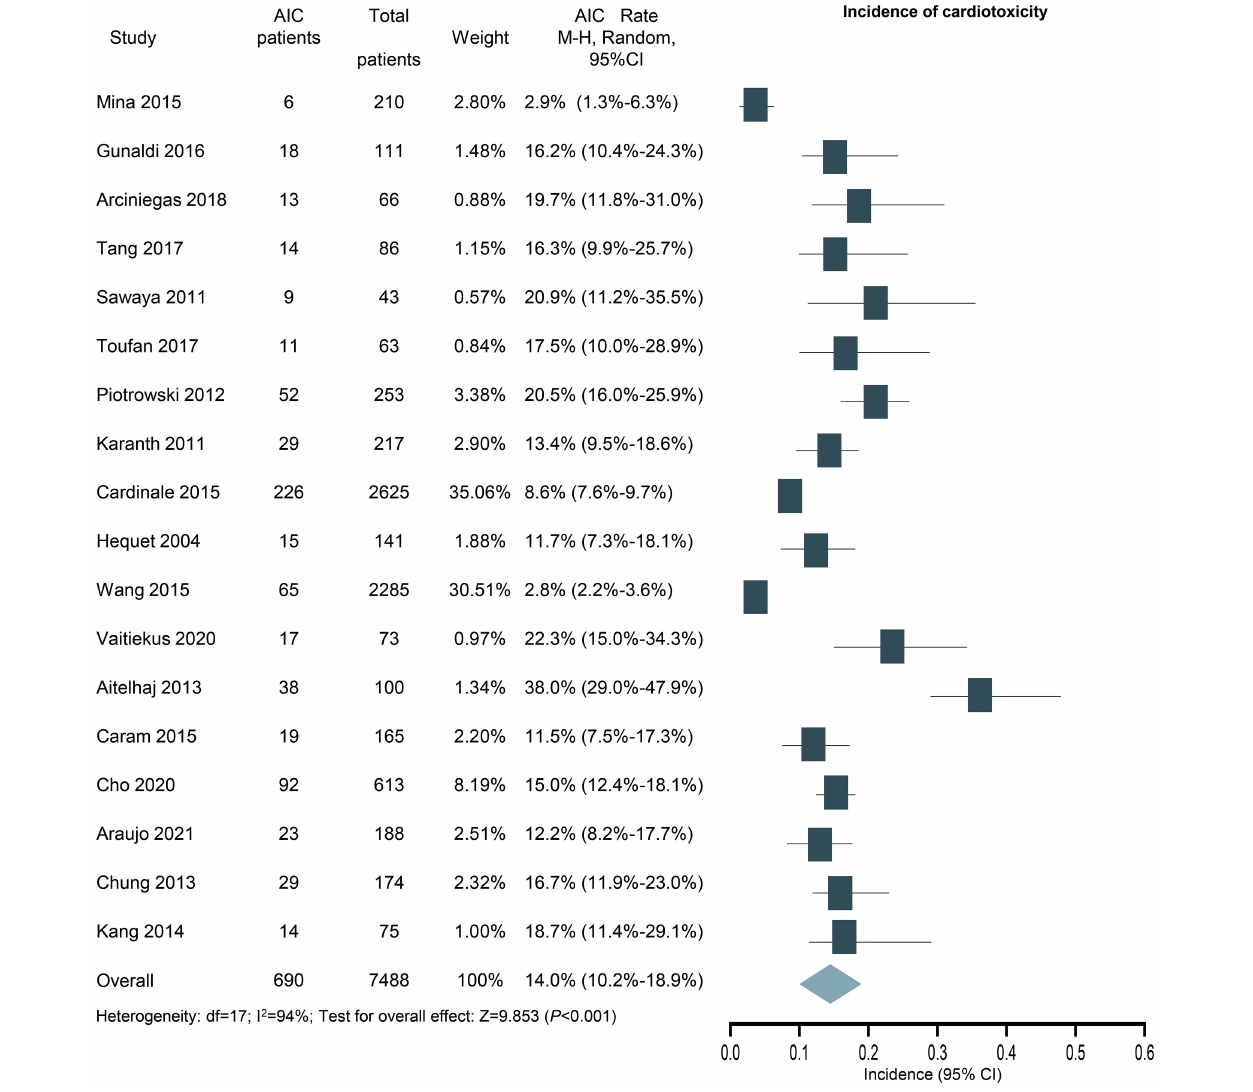
FIGURE 3 | Forest plot of the incidence of anthracycline-induced cardiotoxicity. CI, confidence intervals; OR, odds